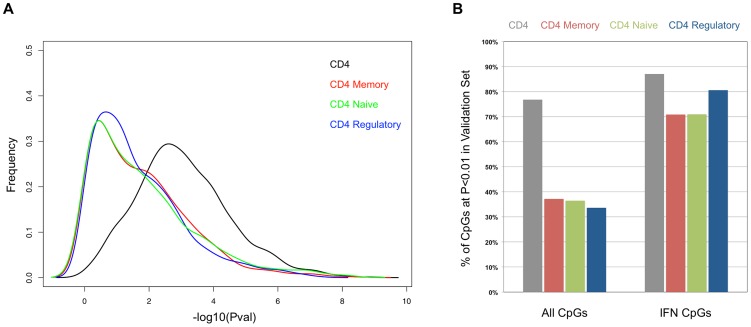
Comparison of the SLE-control p-values in the sorted T-cells from the validation cohort.(A) Distribution of the −log10 of the p-values from association tests in the sorted T-cells cells from the validation cohort at CpGs that were highly significant (p<1×10−8) in the initial cohort. (B) Percentage of CpGs that reported p<0.01 in the sorted T-cells cells from the validation cohort. Values in the left set of bars are from all 1,031 CpGs tested. Values in the right set of bars are from the subset of 62 CpGs near interferon-regulated genes.